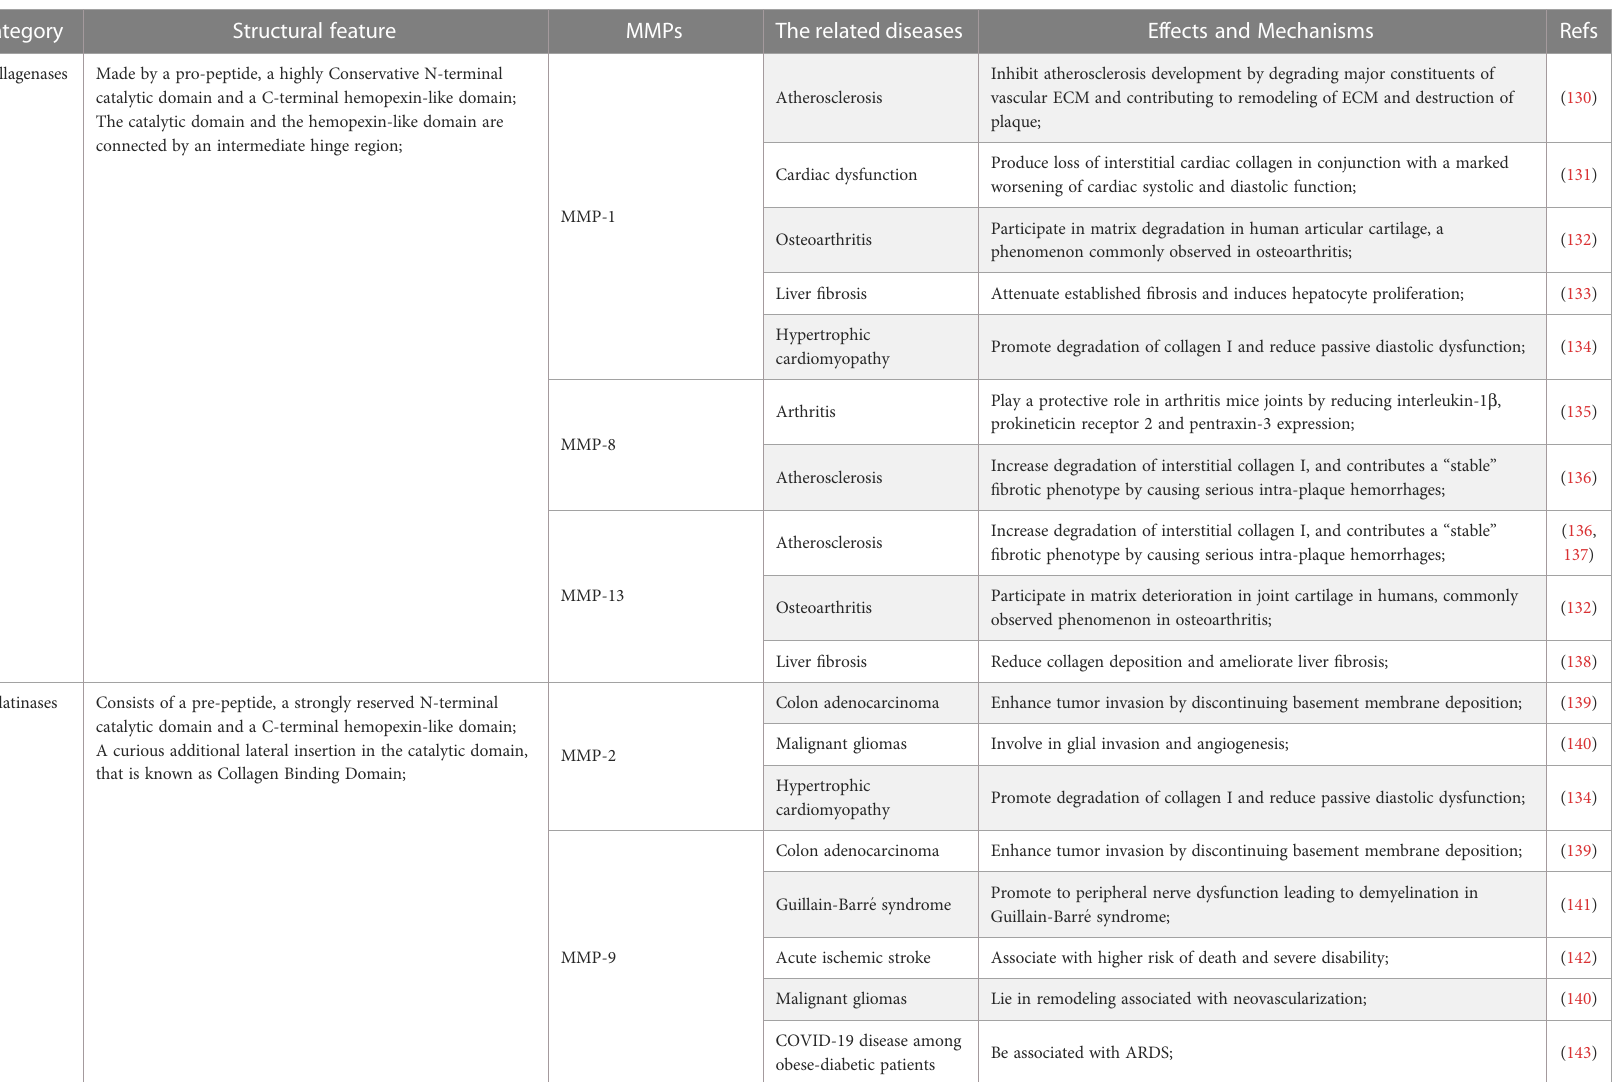
TABLE 1 The classi fi cation of common matrix metalloproteinases (MMPs) implied in pathological